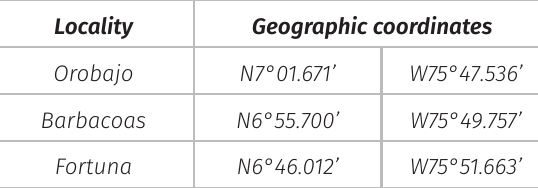
Table I. Geographic coordinates of the cemeteries. Locality Geographic